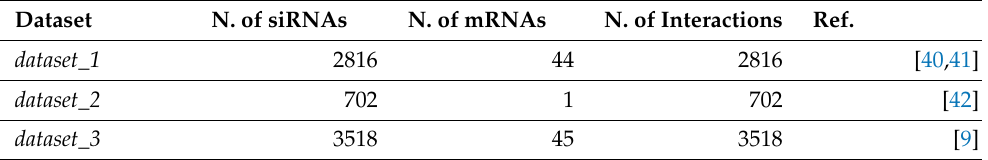
Table 4. Number of siRNAs, mRNAs, and interactions for each dataset.